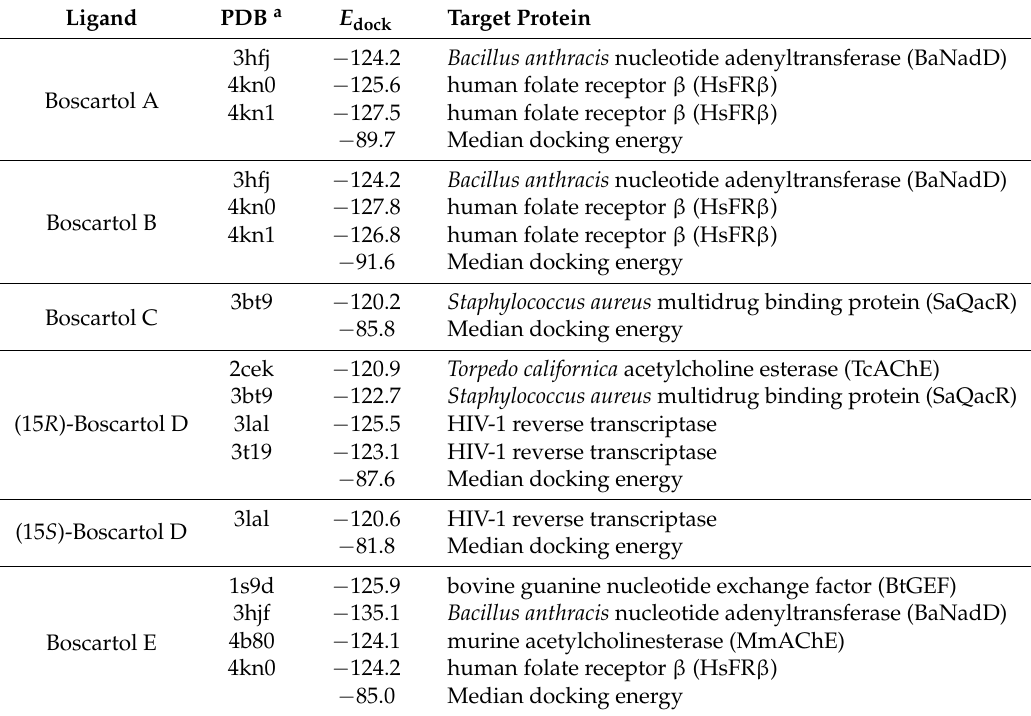
Table 5. Protein targets with the most exothermic docking energies ( E dock , kJ/mol) for Boswellia cneorubenoid